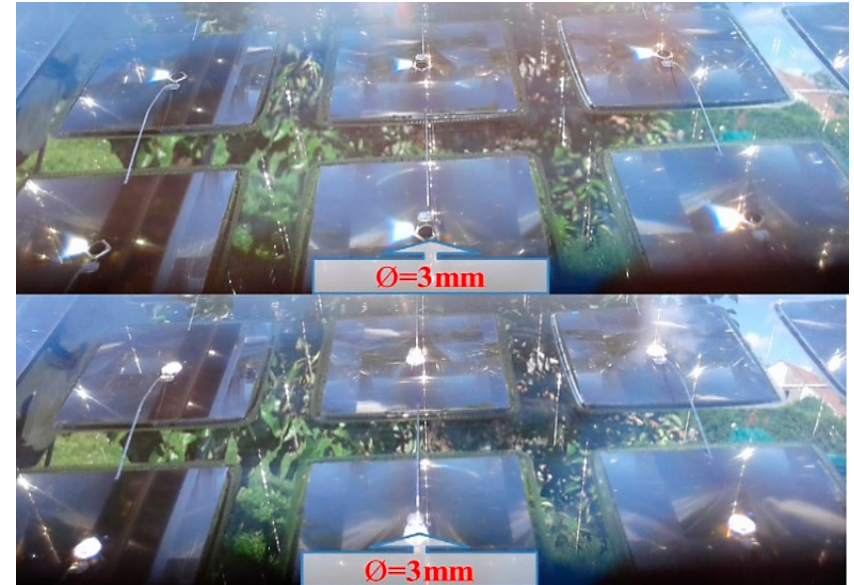
Figure 7. The accuracy of the alignment to the sun can be illustrated with the help of the CPV cells (upper image: incorrect setting; lower image: precise setting). (upper image: incorrect setting; lower image: precise